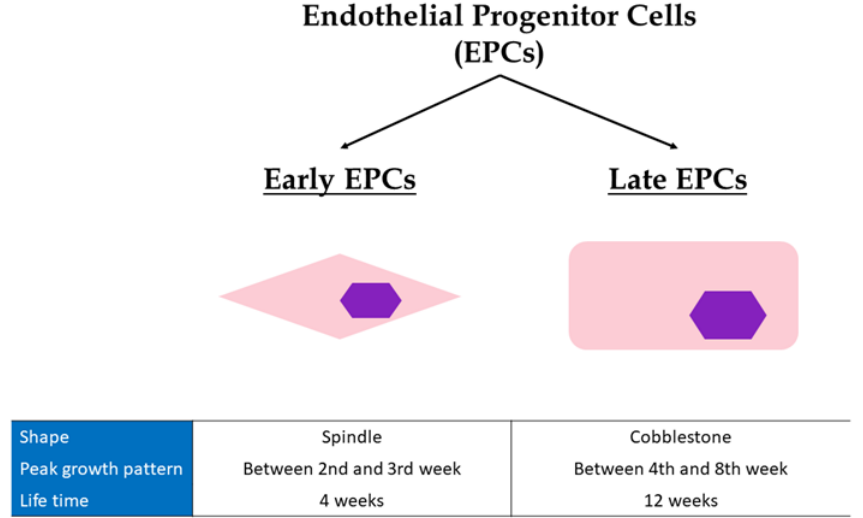
Figure 1. Differences between early and late Endothelial Progenitor cells. EPCs, endothelial progeni- tor cells.